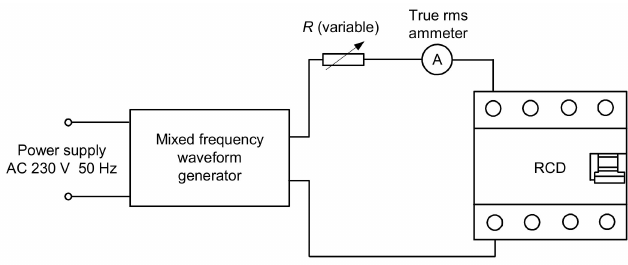
Figure 7. Diagram of the laboratory stand for RCD testing.